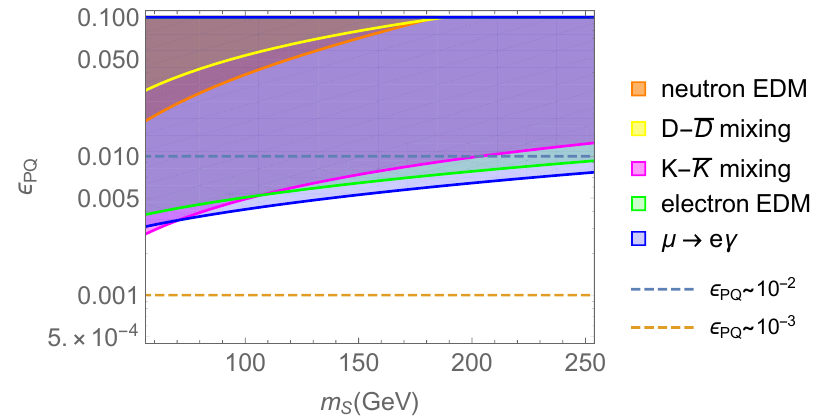
Figure 4. The excluded regions in the (cid:15) PQ (cid:0) m S plane from (cid:13)avor changing neutral current processes and from EDMs. (We use j c (cid:12) j = j s (cid:11) j = 1 =